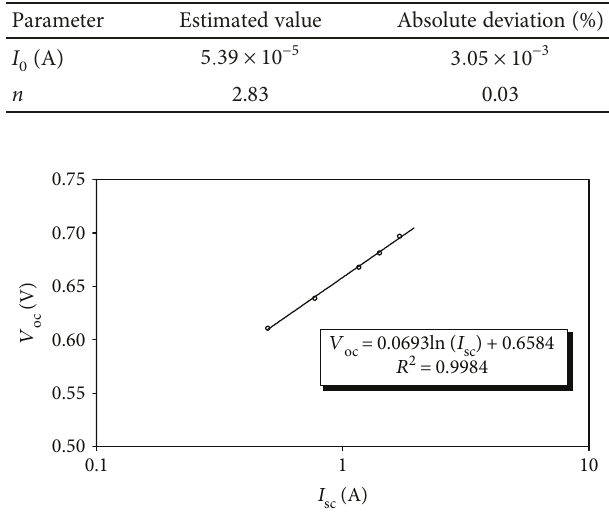
Figure 6: V - I data for the 36-cell module. The symbols indicate oc sc measured data and the solid line indicates simulations. Also shown is the e ff ect of low cell shunt resistances on the relation between V and I (dashed line). sc